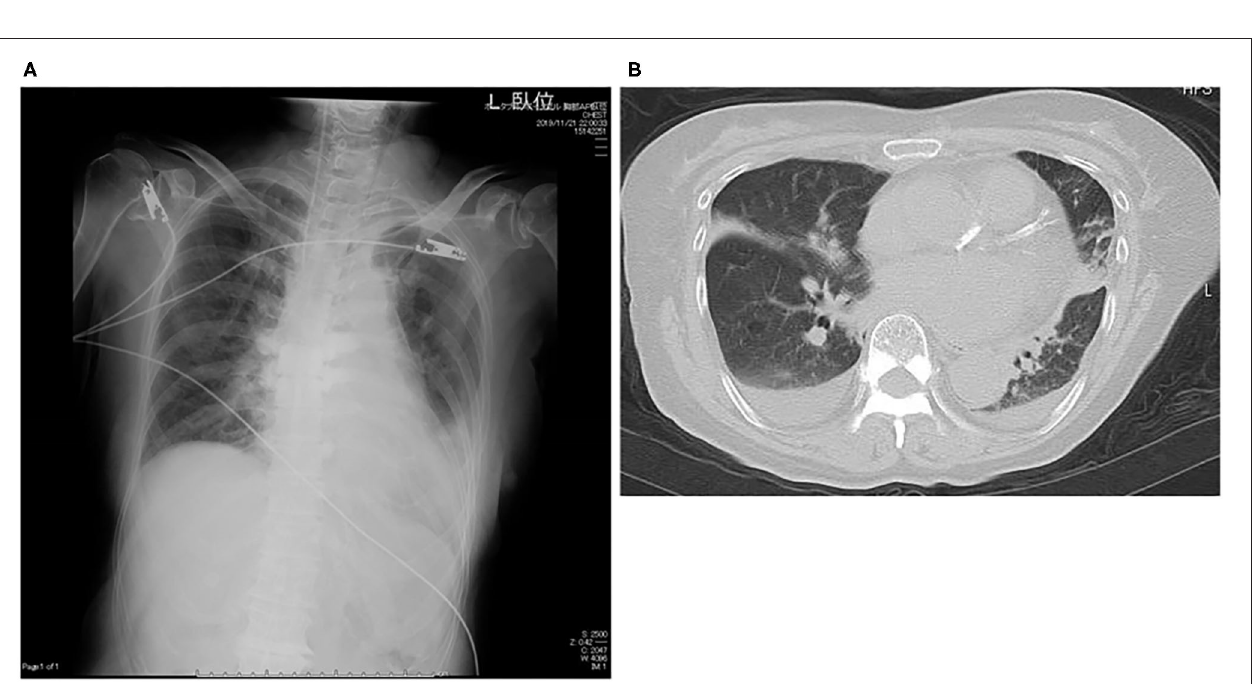
FIGURE 2 | Chest X-ray on admission (A) and chest computed tomography during hospitalization (B) .